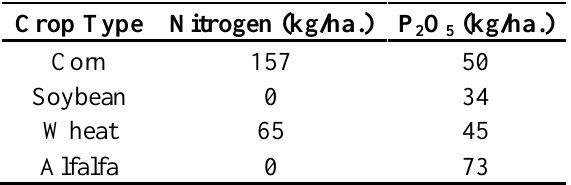
Table 3. Fertilizer application for main crops .